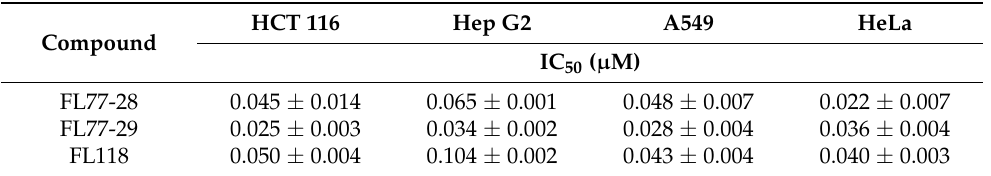
Table 1. IC 50 values of FL118, FL77-28, and FL77-29 against the HCT 116, HepG-2, A549, and HeLa cell lines, determined by MTT assay. Data represent the mean ± SD ( n = 3).